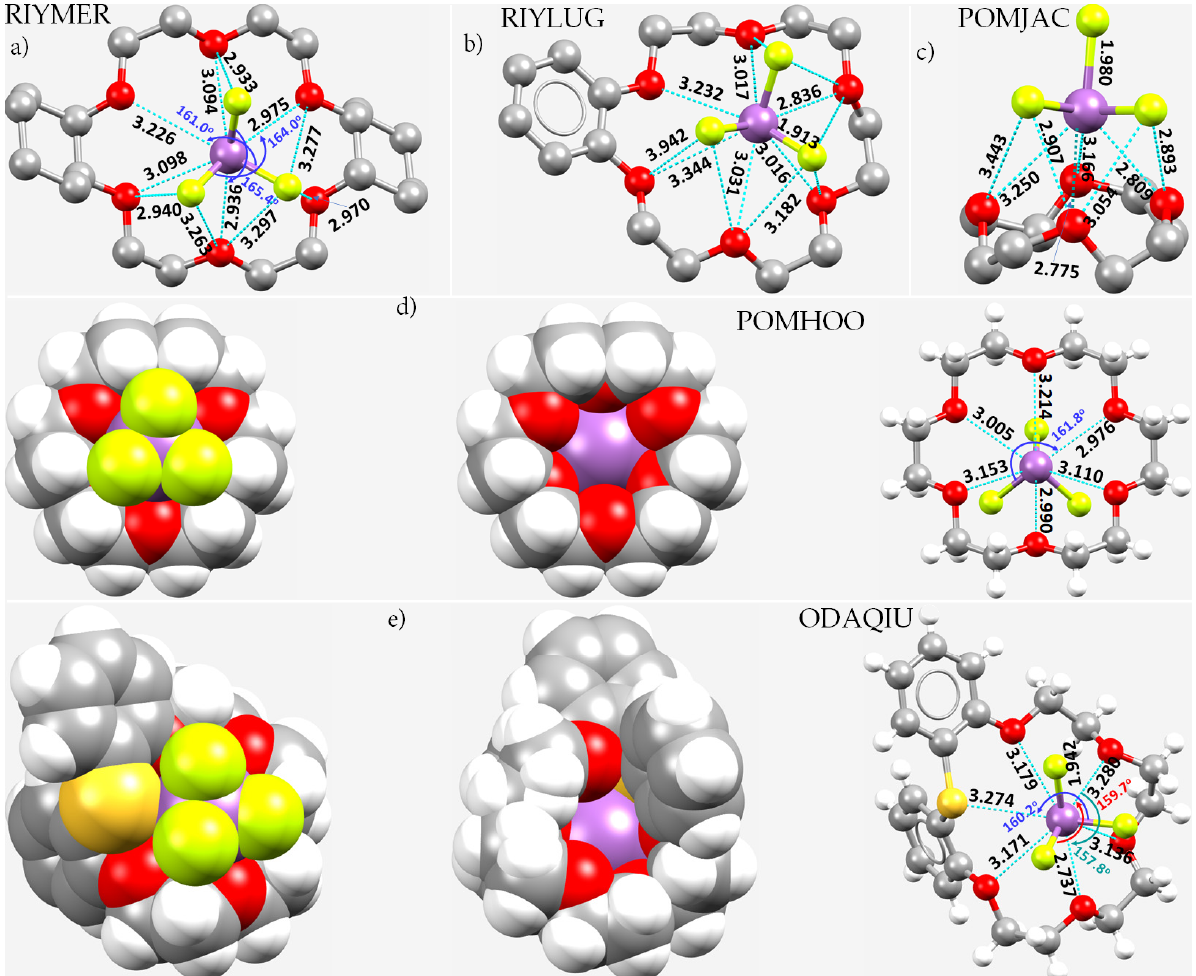
Figure 28. ( a – e ) Examples of some host–guest complexes of SbF 3 with crown-ethers. Selected bond lengths and bond angles are in Å and degrees, respectively. ( a ) ( cis-anti-cis -dicyclohexyl-8-crown- 6)SbF 3 [168]; ( b ) (benzyl-18-crown-6)SbF 3 [168]; ( c ) (12-crown-4)SbF 3 [169]; ( d ) (18-crown-6)SbF 3 [169]; and ( e ) ([1.5]dibenzothia-18-crown-6)SbF 3 [170]. For clarity, the H-atoms are omitted in the first two cases, and potential secondary interactions are omitted for most cases. Atom type is shown in some cases, and the CSD ref. code is given. Benzene solvate is not included in ( e ) for clarity. Selected bong lengths and bond distances are shown in Å and degree, respectively.